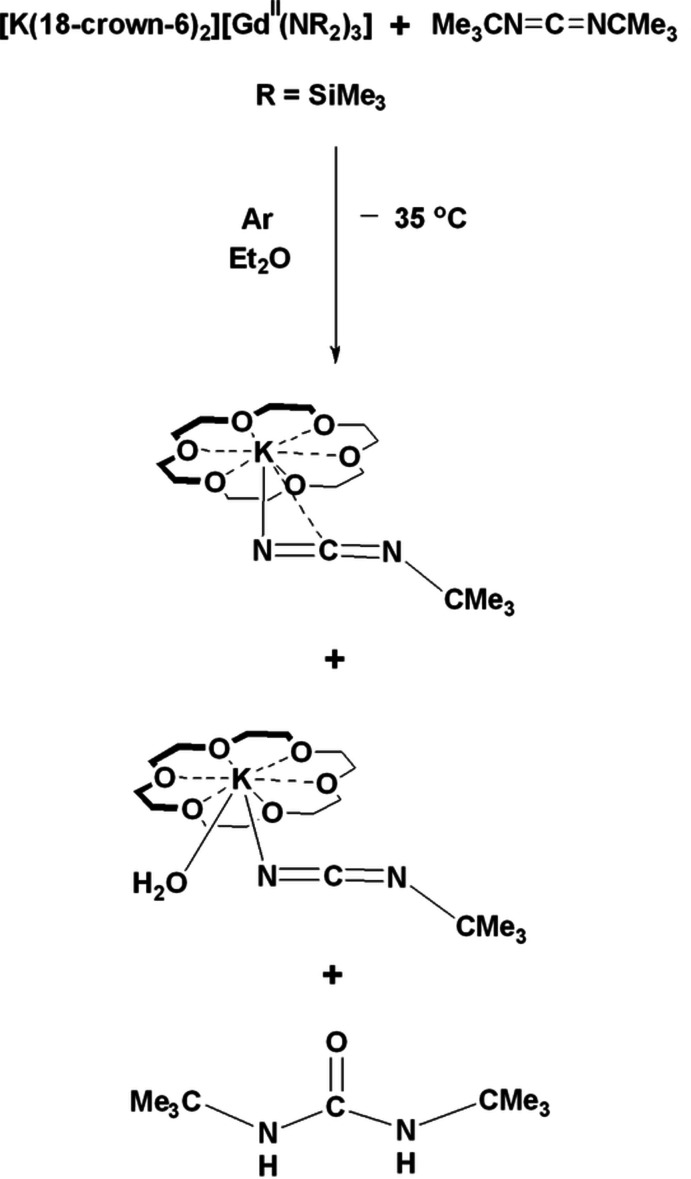
The reaction scheme.